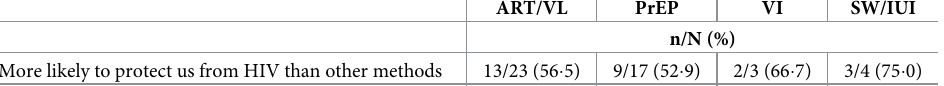
Table 3. Reasons a that couples (N = 23) gave for selecting their chosen safer conception method(s) at enrolment. ART/VL PrEP VI